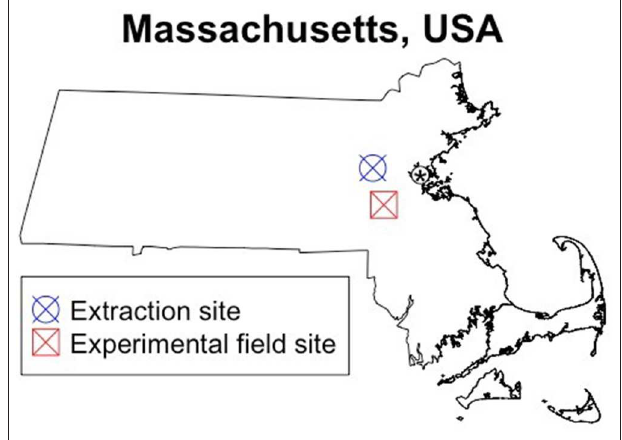
FIGURE 1 | Map of locations of extraction and experimental field sites in eastern MA, USA; *Boston, MA, the state capital.